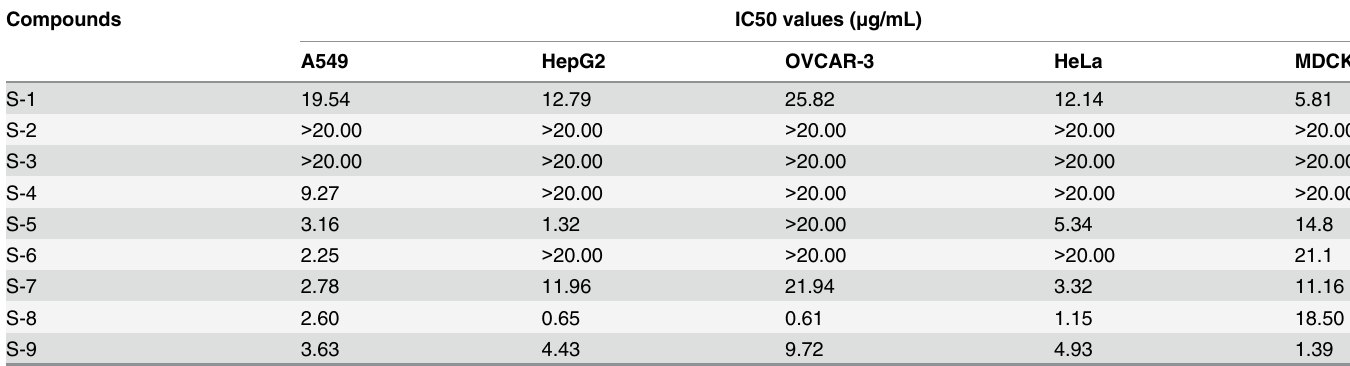
Table 1. IC50 values of emodin and its derivatives in different cell